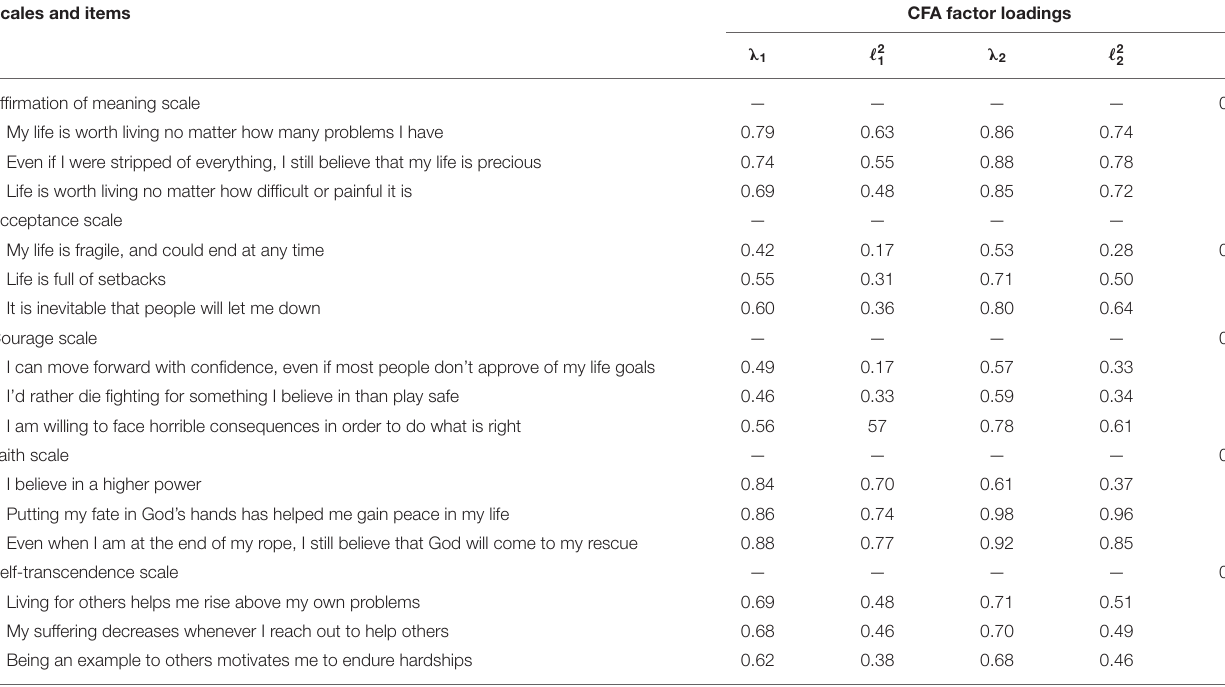
TABLE 1 | Scale items, internalizing domains, and factor loadings. Scales and